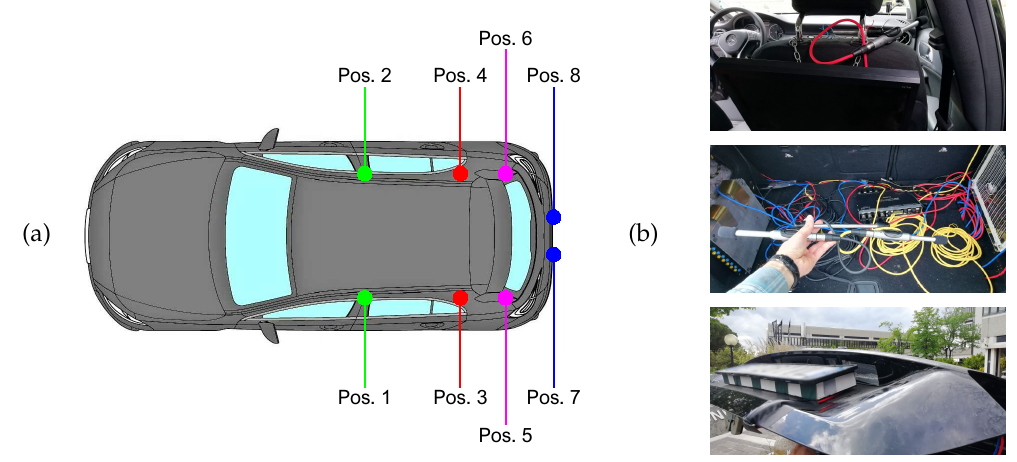
Figure 4. Setup of the car equipped for environmental recordings. ( a ) Layout of the microphone positions: positions1–2 at the side of the front seats, positions3–4 at the side of the rear seats, positions5–6 in the trunk, and positions7–8 behind the license plate. ( b ) Details of the microphones, from top to bottom: (top), at position2; (middle), in the trunk at positions5–6; (bottom), hidden behind the license plate at